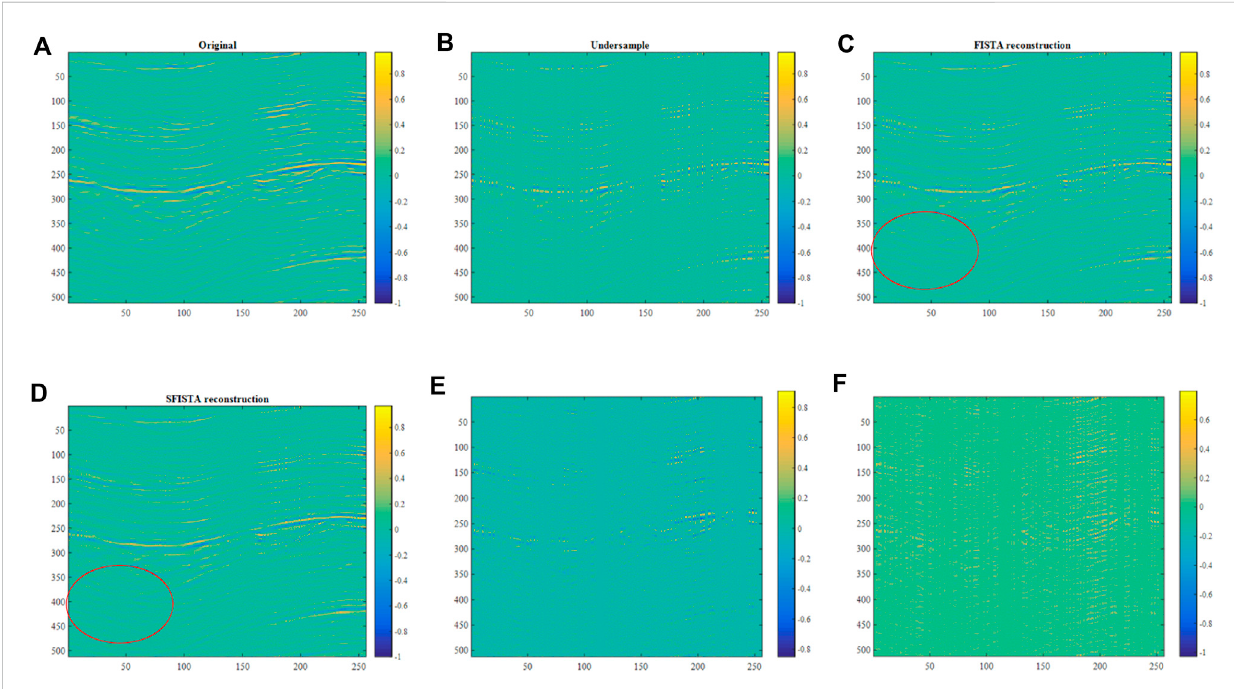
FIGURE 5 Reconstruction results of fi eld data in the contourlet domain. (A) Original data; (B) 50% of randomly missing data; (C) interpolated data obtained by theFISTA method; (D) interpolated dataobtainedbytheSFISTAmethod; (E) reconstructed errorsobtained bytheFISTA method; (F) reconstructederrors obtained by the SFISTA method.